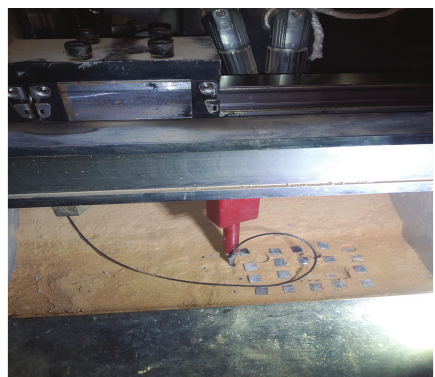
Figure 7: Pipe piles press-in process.